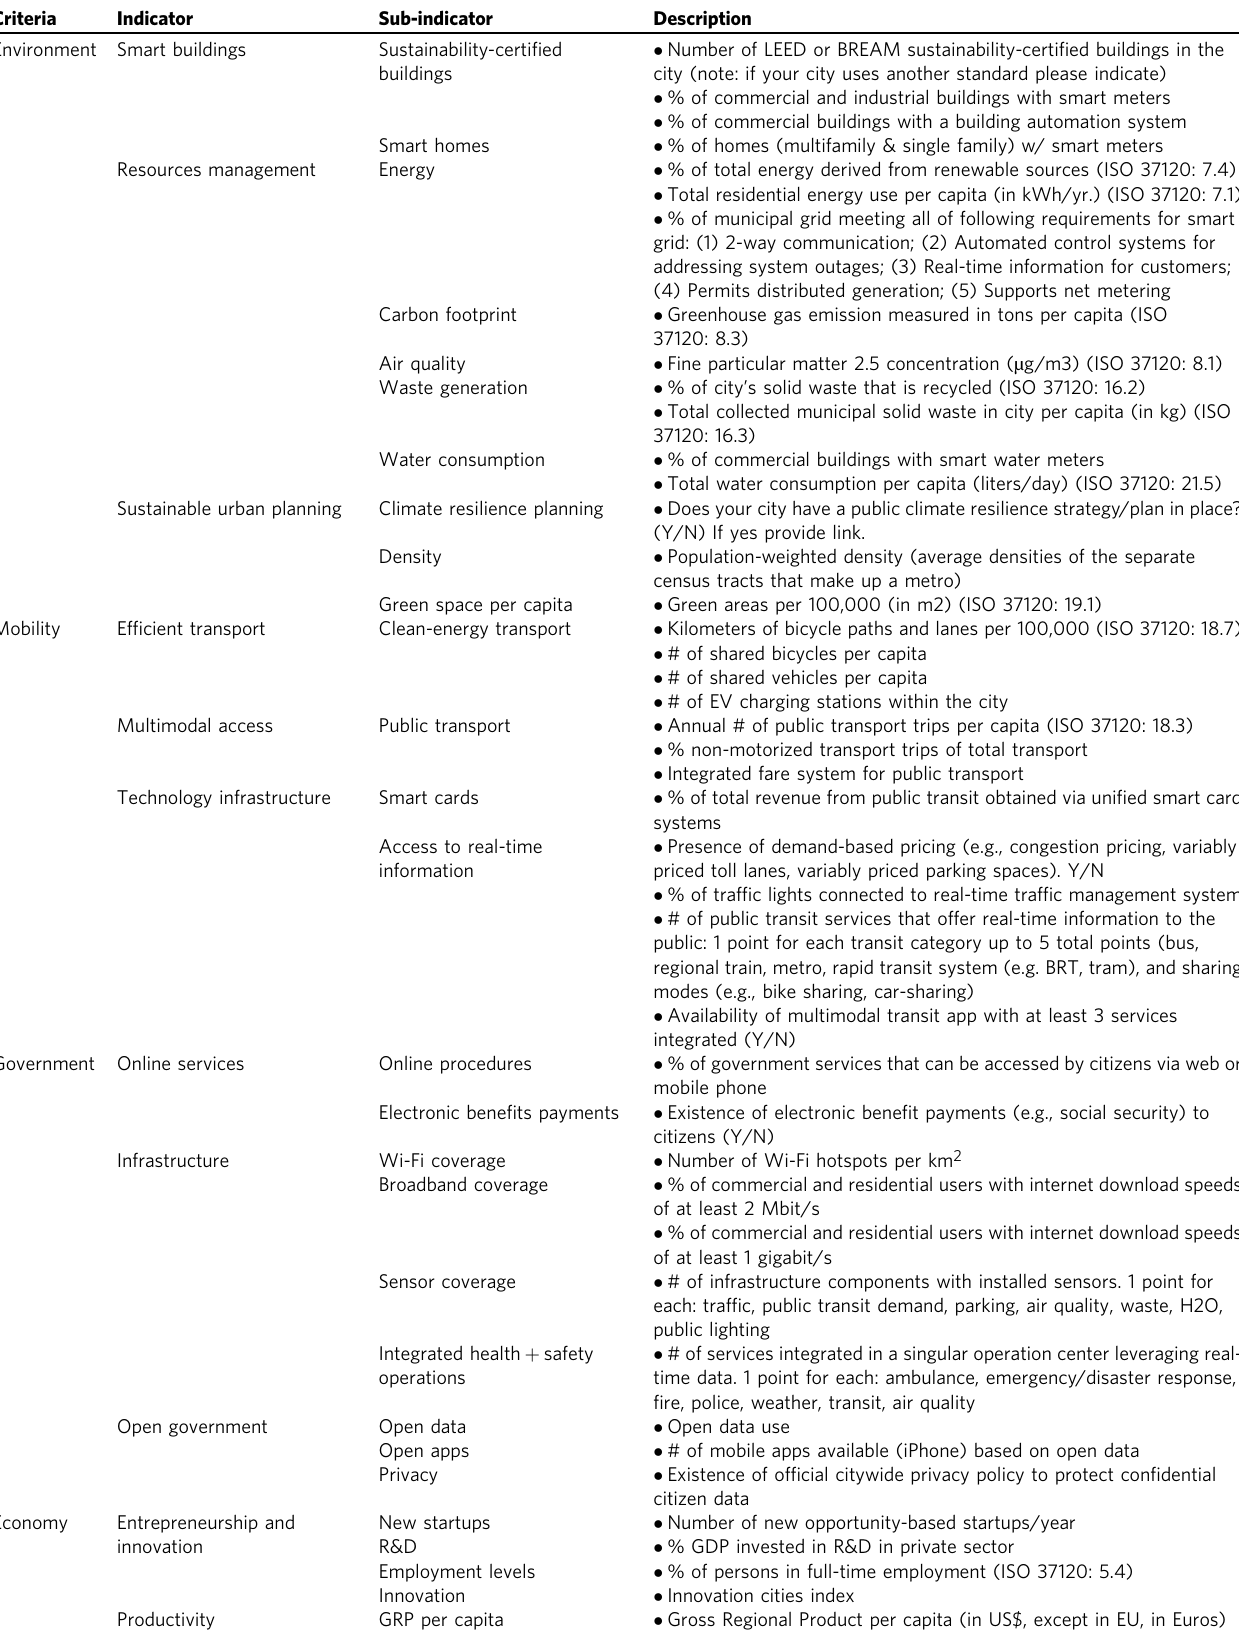
Table 1 Smart city indicators and